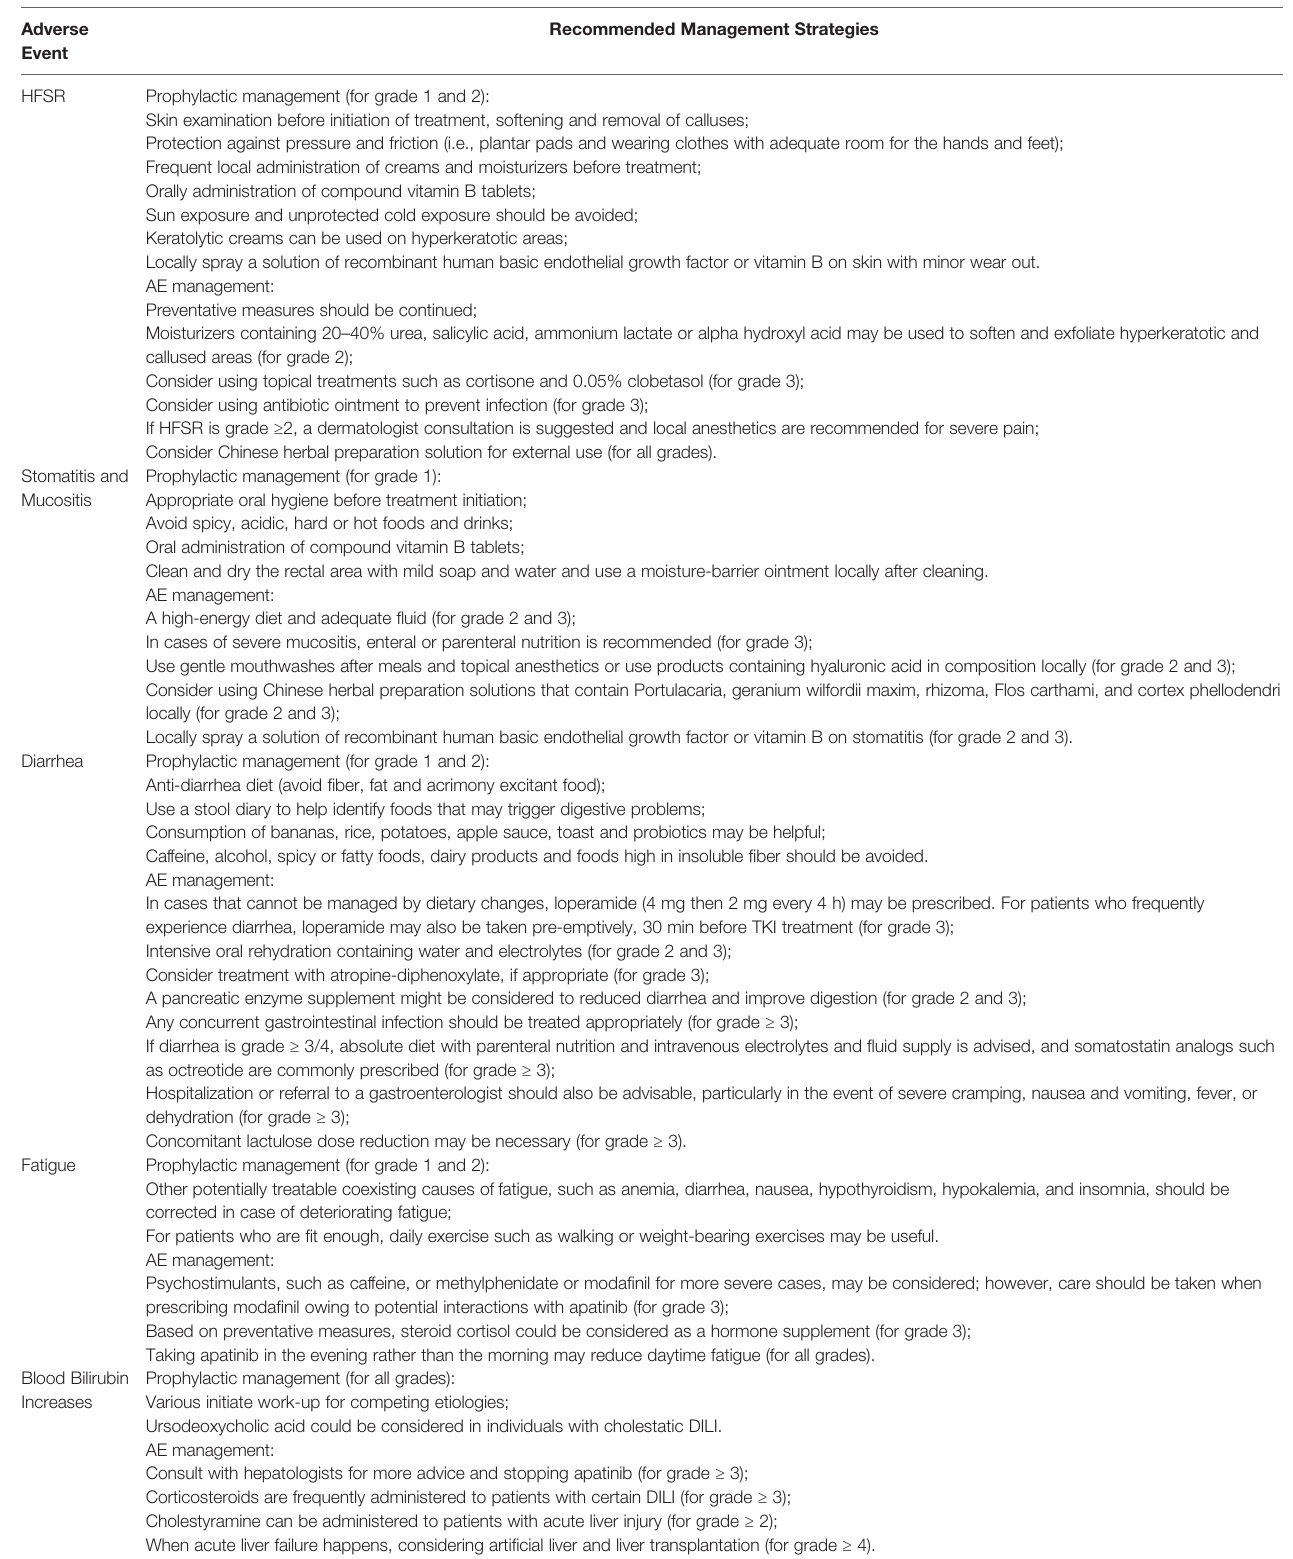
TABLE 4 | Management of common adverse events associated with apatinib for advanced osteosarcoma. Adverse